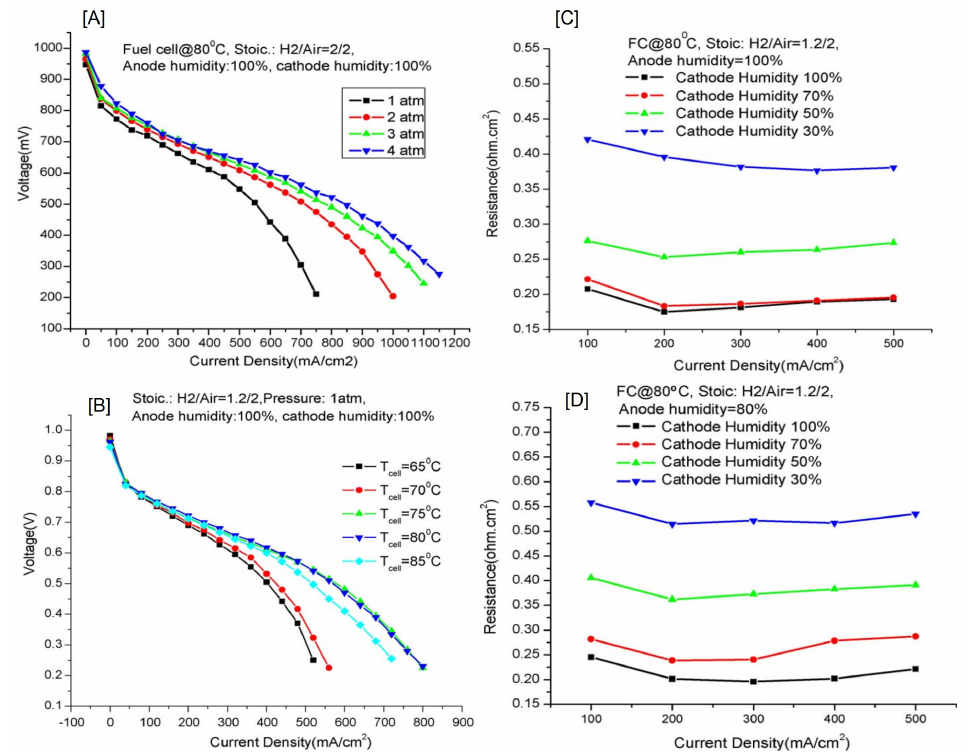
Figure 10. Effect of ( A ) pressure, ( B ) temperature and ( C , D ) cathode and anode humidity on proton exchange membrane fuel cell (PEMFC) performance as experimentally tested by Yan et al.